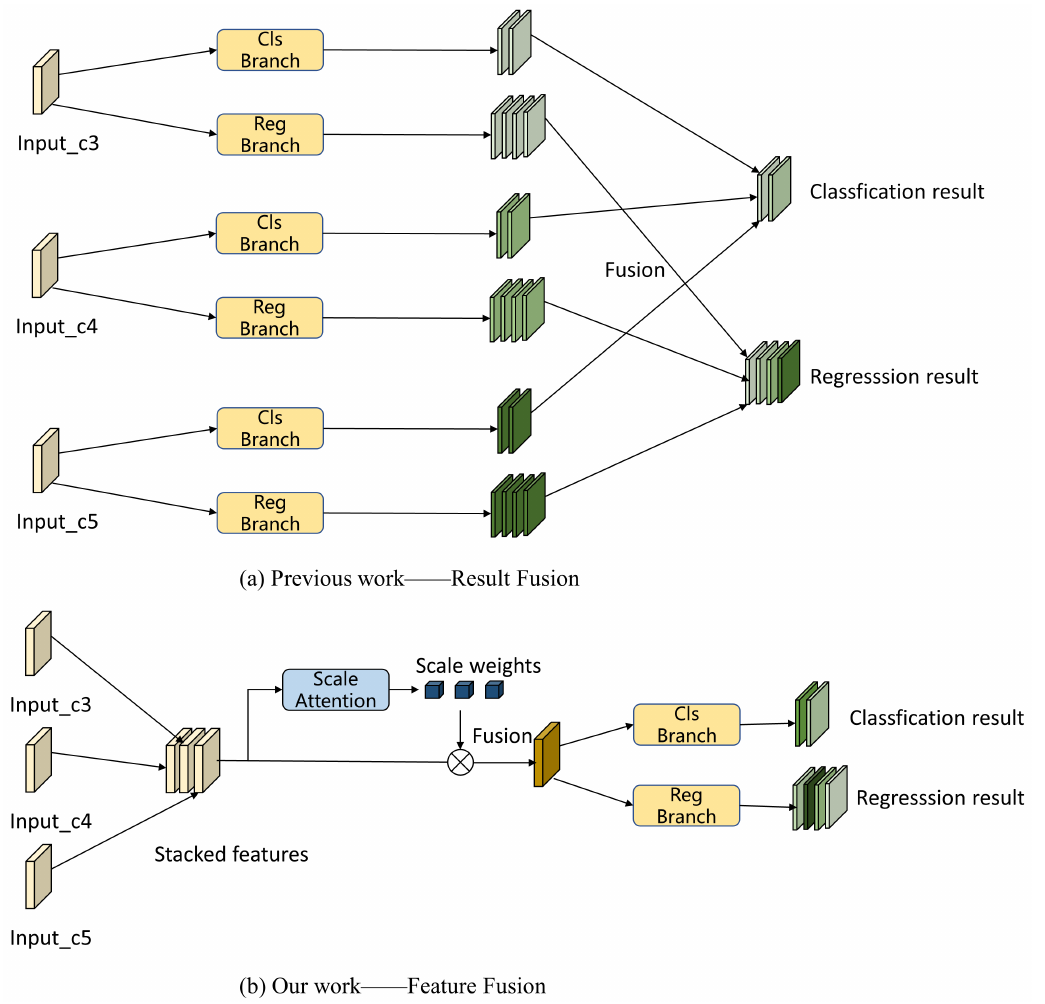
Figure 1. Comparison of previous work and our work. ( a ) Previous works use result fusion to fuse the result maps and obtain the tracking results. The classification branch and regression branch first decode the features of the simialrity response map to obtain the result map, and then fuse it. ( b ) Our work uses a novel scale attention to fuse the multi-level similarity response maps. Subsequently, the two branches decode it to produce the tracking